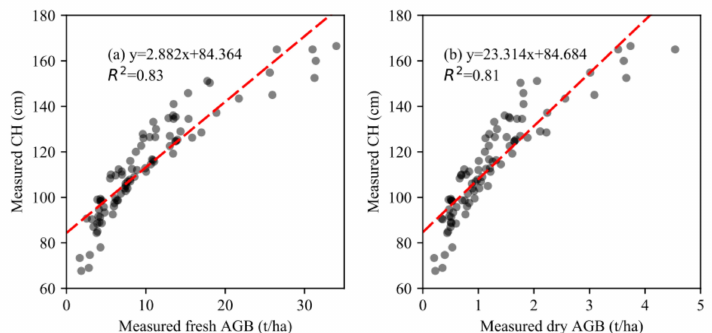
Figure 14. Scatter plots of measured crop height and measured maize ( a ) fresh AGB and ( b ) dry AGB ( n =